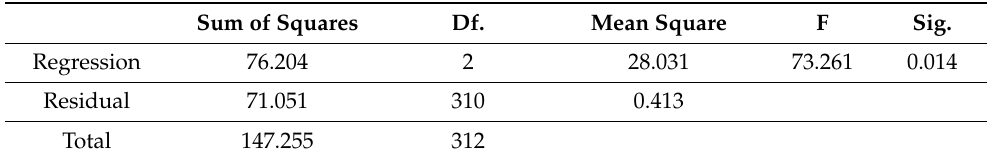
Table 8. ANOVA. Sum of Squares Df. Mean Square F